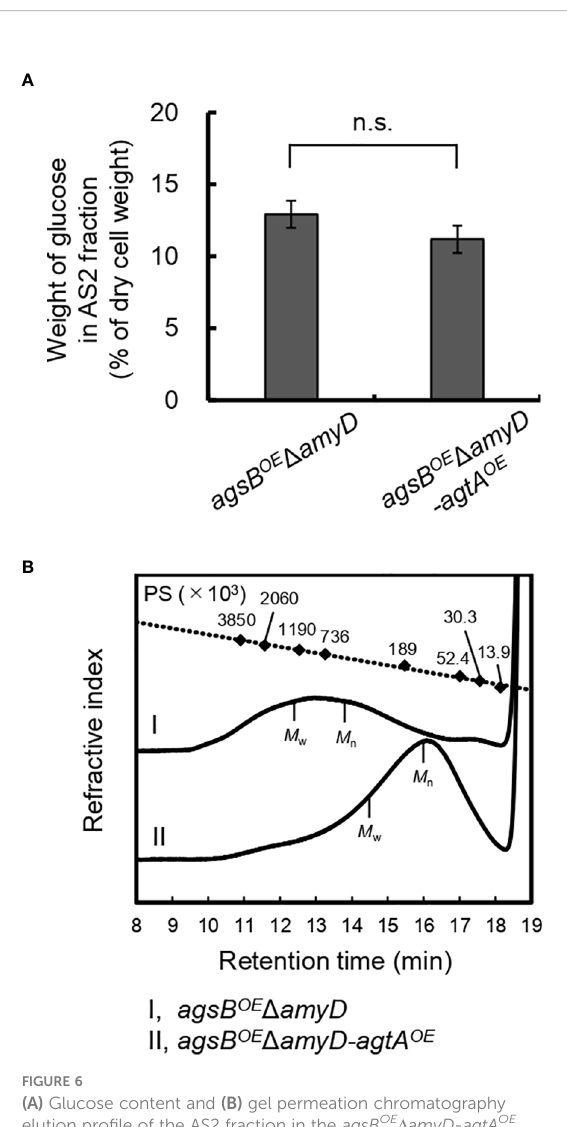
FIGURE 6 (A) Glucose content and (B) gel permeation chromatography elution pro fi le of the AS2 fraction in the agsB OE D amyD-agtA OE strain of A . nidulans . (A) Conidia (5 × 10 5 /mL) of each strain were inoculated into CD medium and rotated at 160 rpm at 37°C for 24 h. Error bars represent the standard error of the mean calculated from three replicates. n.s., not signi fi cant in t -test ( P ≥ 0.05). (B) The AS2 fraction from 24-h-cultured mycelia of each strain was dissolved in 20 mM LiCl/ N , N -dimethylacetamide. The elution pro fi le was monitored with a refractive index detector. Molecular weights of the glucan peaks were determined from a calibration curve of polystyrene (PS) standards ( ♦ ). M w , weight-average molecular weight; M n , number-average molecular